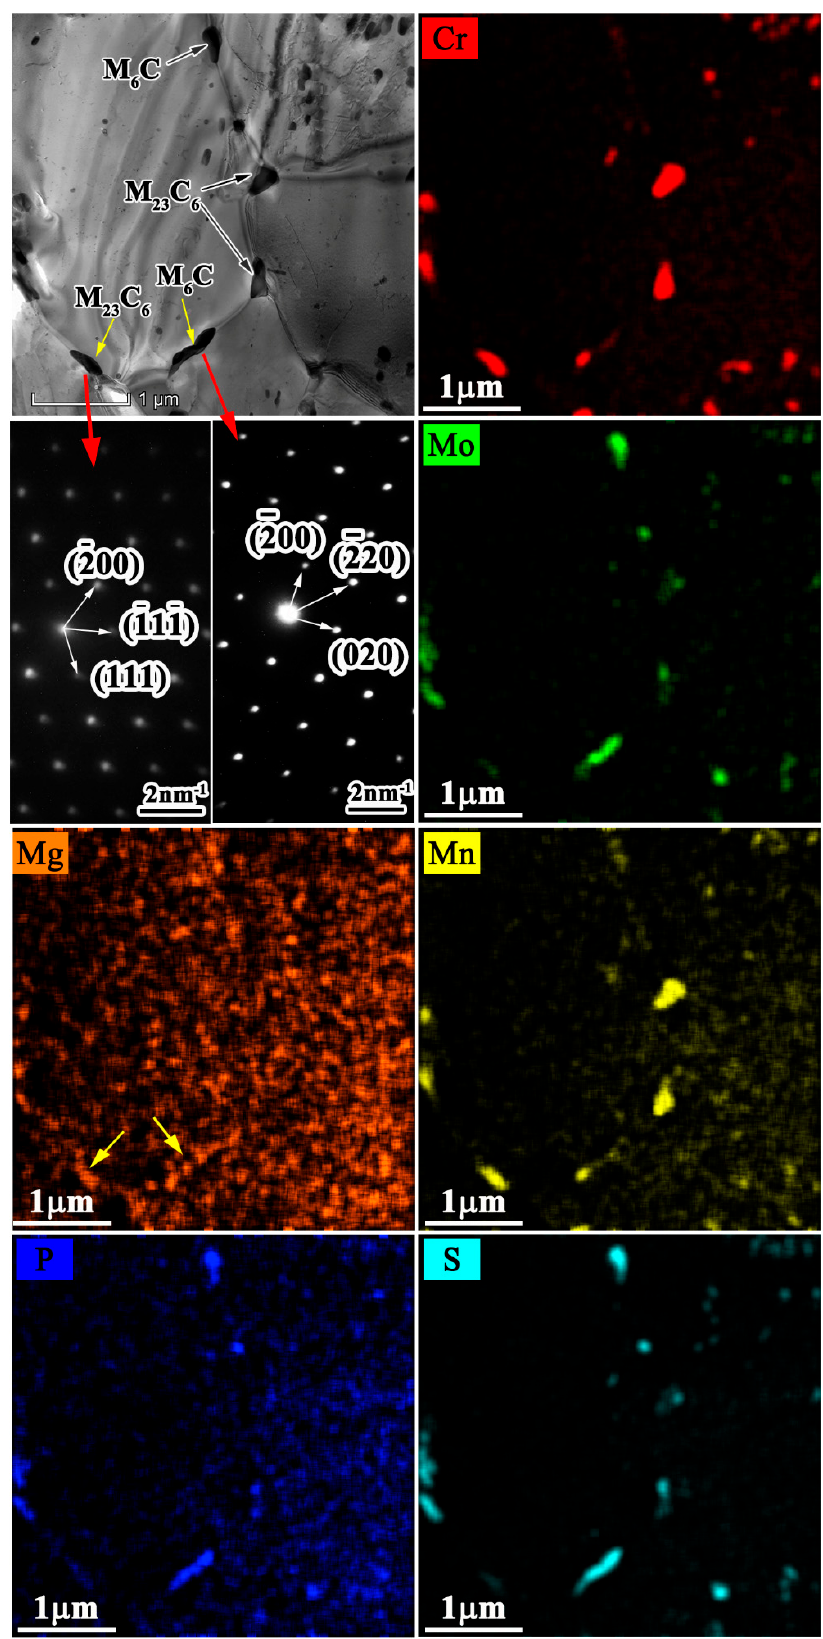
Figure 12. TEM images show the element map distribution of S2 after aging 5000 h at 580 °C.